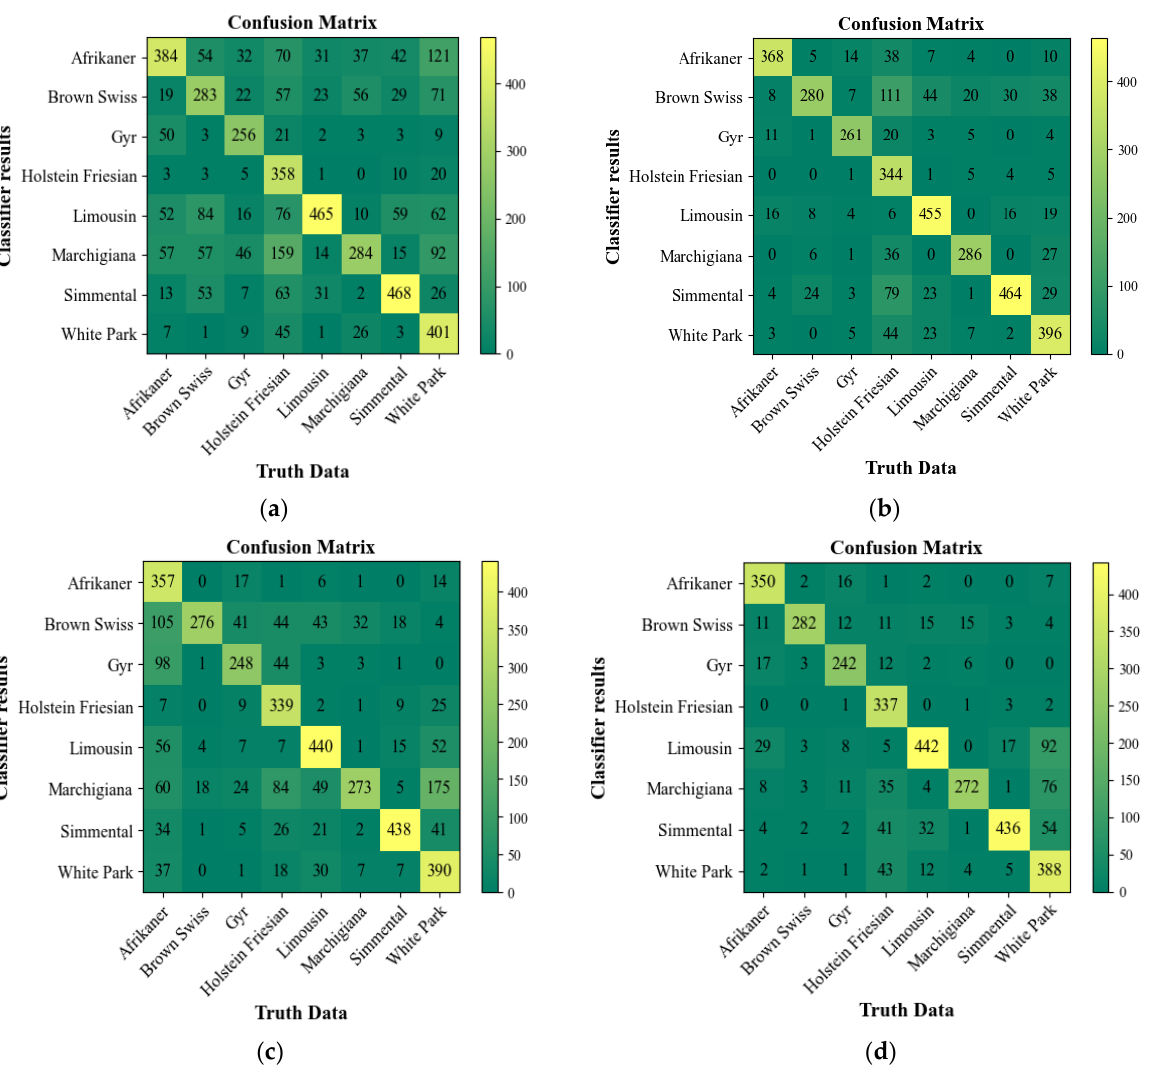
Figure 15. Confusion matrix obtained with network size and IoU _threshold ( a ) 416 × 416, 0.50 ( b ) 416 × 416, 0.75 ( c ) 608 × 608, 0.50 ( d ) 608 × 608, 0.75.